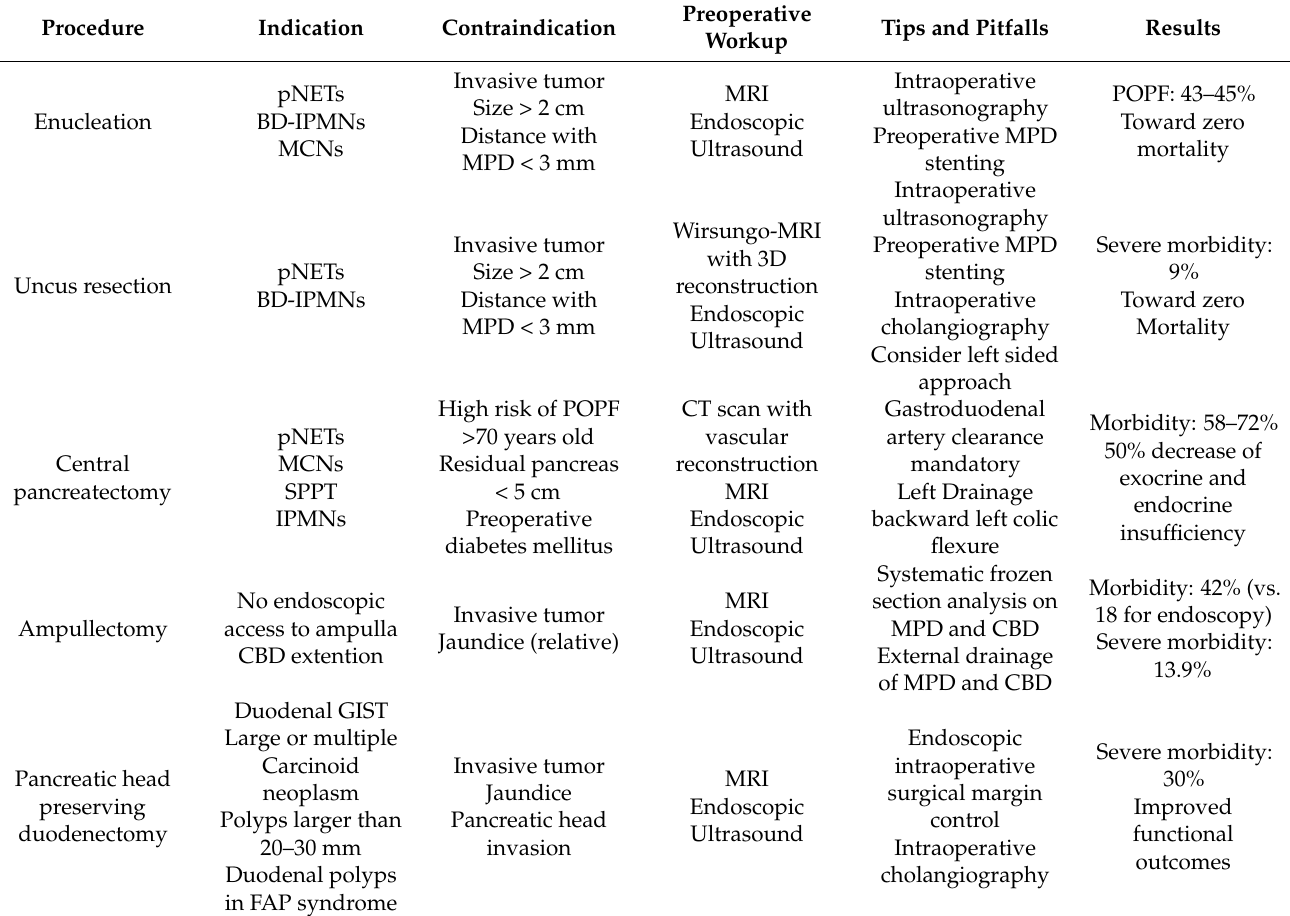
Table 1. Summarized information on duodenal and pancreatic parenchymal sparing